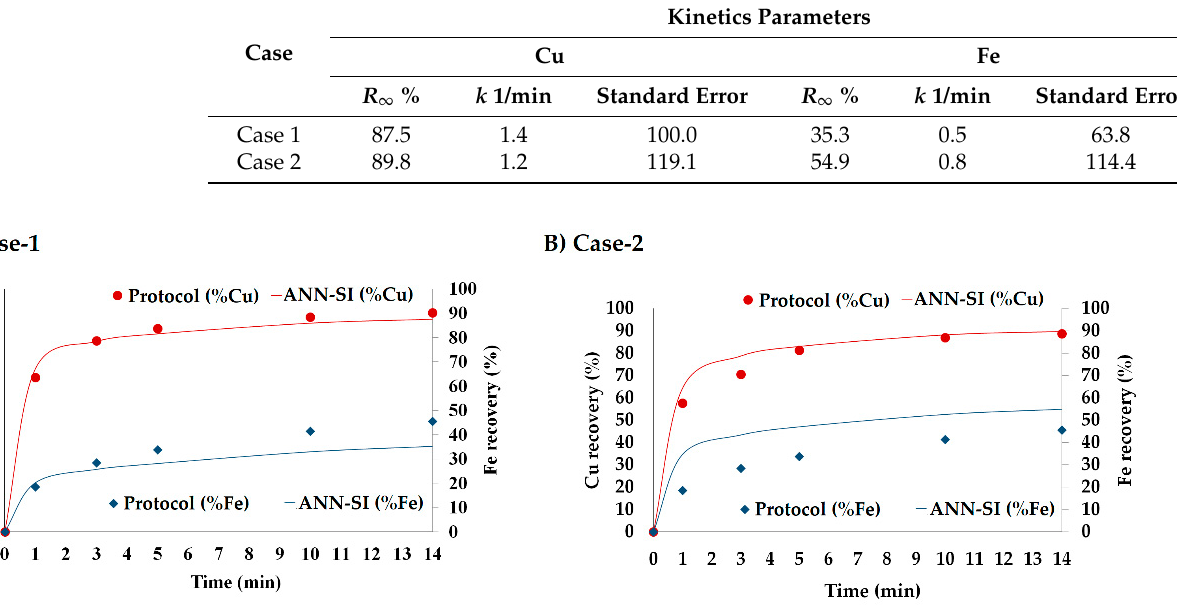
Figure 6. Cu and Fe recovery versus time for optimal conditions.